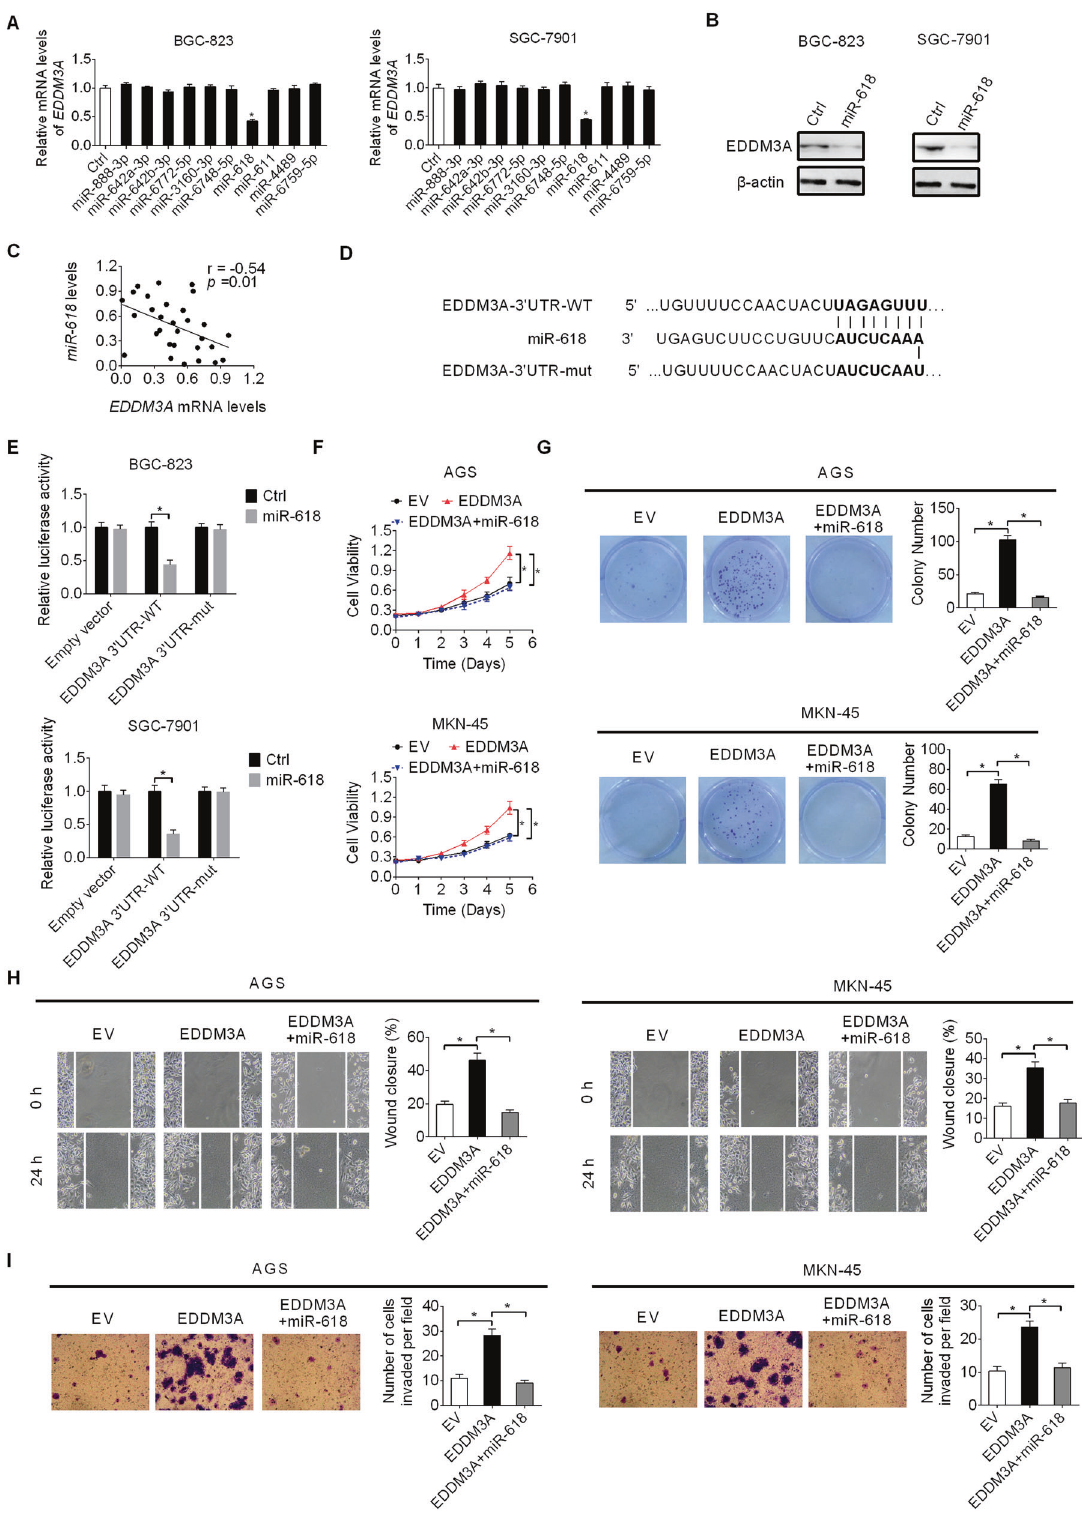
Fig. 5 EDDM3A up-regulation is mainly mediated by down-regulation of miR-618 in GC. A , B The effect of miRNA transfection on the expression of EDDM3A was determined by qRT-PCR and Western blot analysis in BGC-823 and SGC-7901 cells. C Correlation between the expressions of miR-618 and EDDM3A in tumor tissues of GC was analyzed ( n = 30). D The binding sites of miR-618 were constructed for wild- type EDDM3A 3 ′ -UTR and the corresponding mutant type. E Luciferase assay of EDDM3A 3 ′ -UTR and EDDM3A 3 ′ -UTR-mut reporters cotransfected with miR-618 mimic in BGC-823 and SGC-7901 cells. F , G Effects of miR-618 transfection on cell viability and colony formation regulated by EDDM3A were determined in AGS and MKN-45 cells. H , I Effects of miR-618 transfection on cell migration and invasion regulated by EDDM3A were determined in AGS and MKN-45